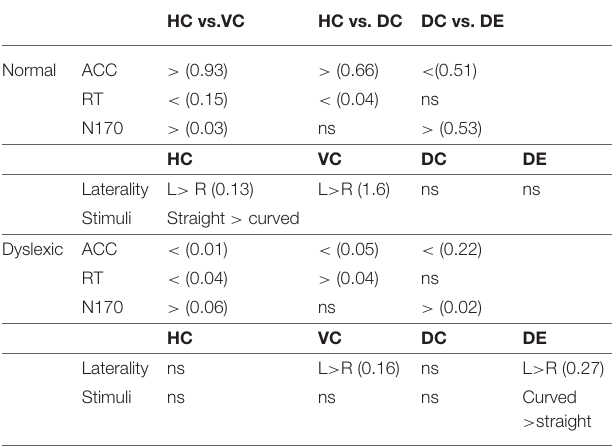
TABLE 3 | Summary table of behavioral and EEG results. HC